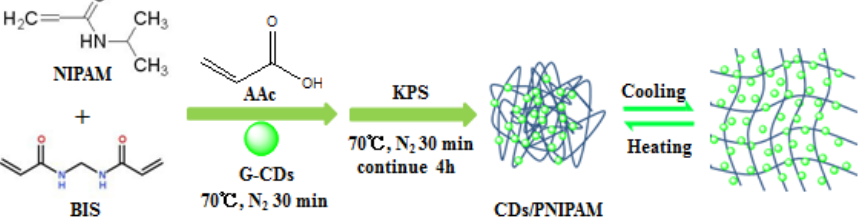
Figure 2. Synthesis and phase transition diagram of CDs/PNIPAM.